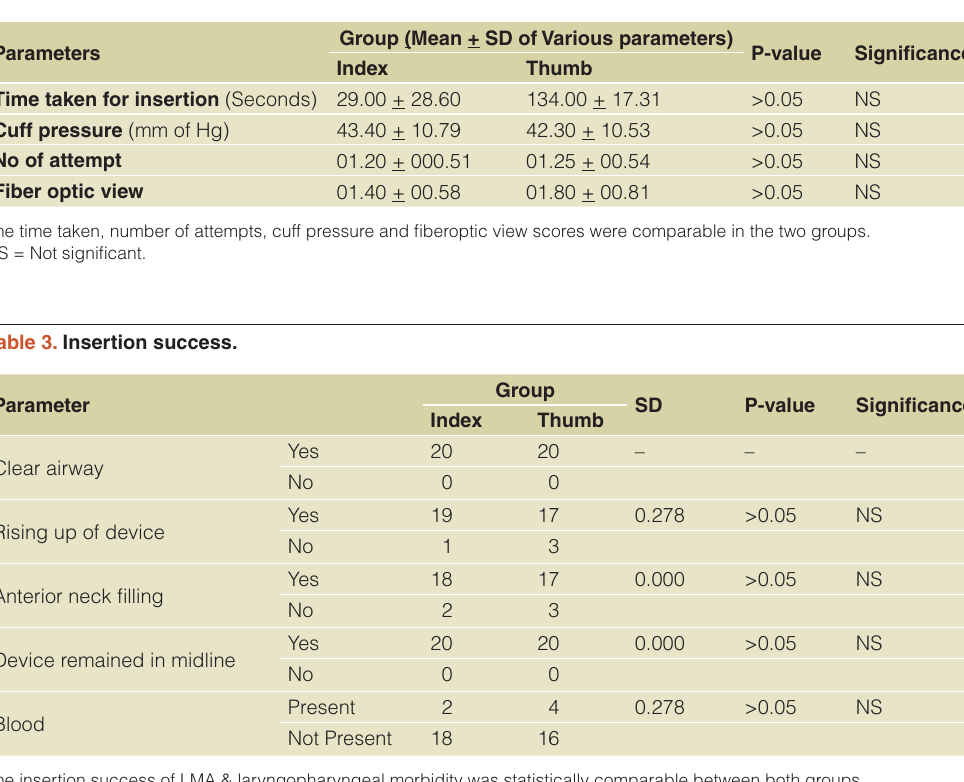
Table 2. Ease of insertion.